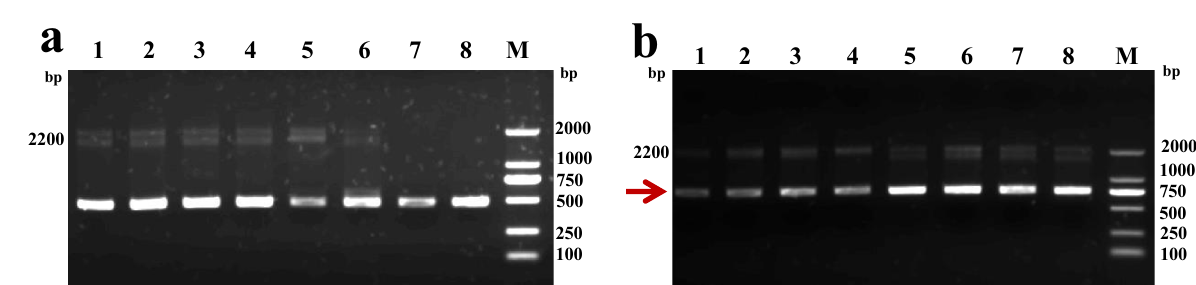
Figure 5. PCR detection of Pichia pastoris GS115 transformation with the recombinant plasmid pPIC9K- Hirudin . ( a ) P. pastoris GS115 cells transformed with the empty pPIC9K plasmid (GS115/pPIC9K). ( b ) P. pastoris GS115 transformants with pPIC9K-hirudin (GS115/pPIC9K-hirudin) (M: Marker DL2000). The recombinant integrated target gene is indicated using a red arrow (~ 720 bp). The PCR products were analyzed on a 1.5% agarose gel. The original gel is presented in Fig.